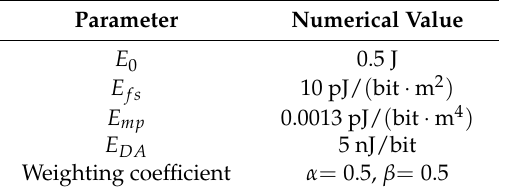
Table 1. Table of simulation experiment